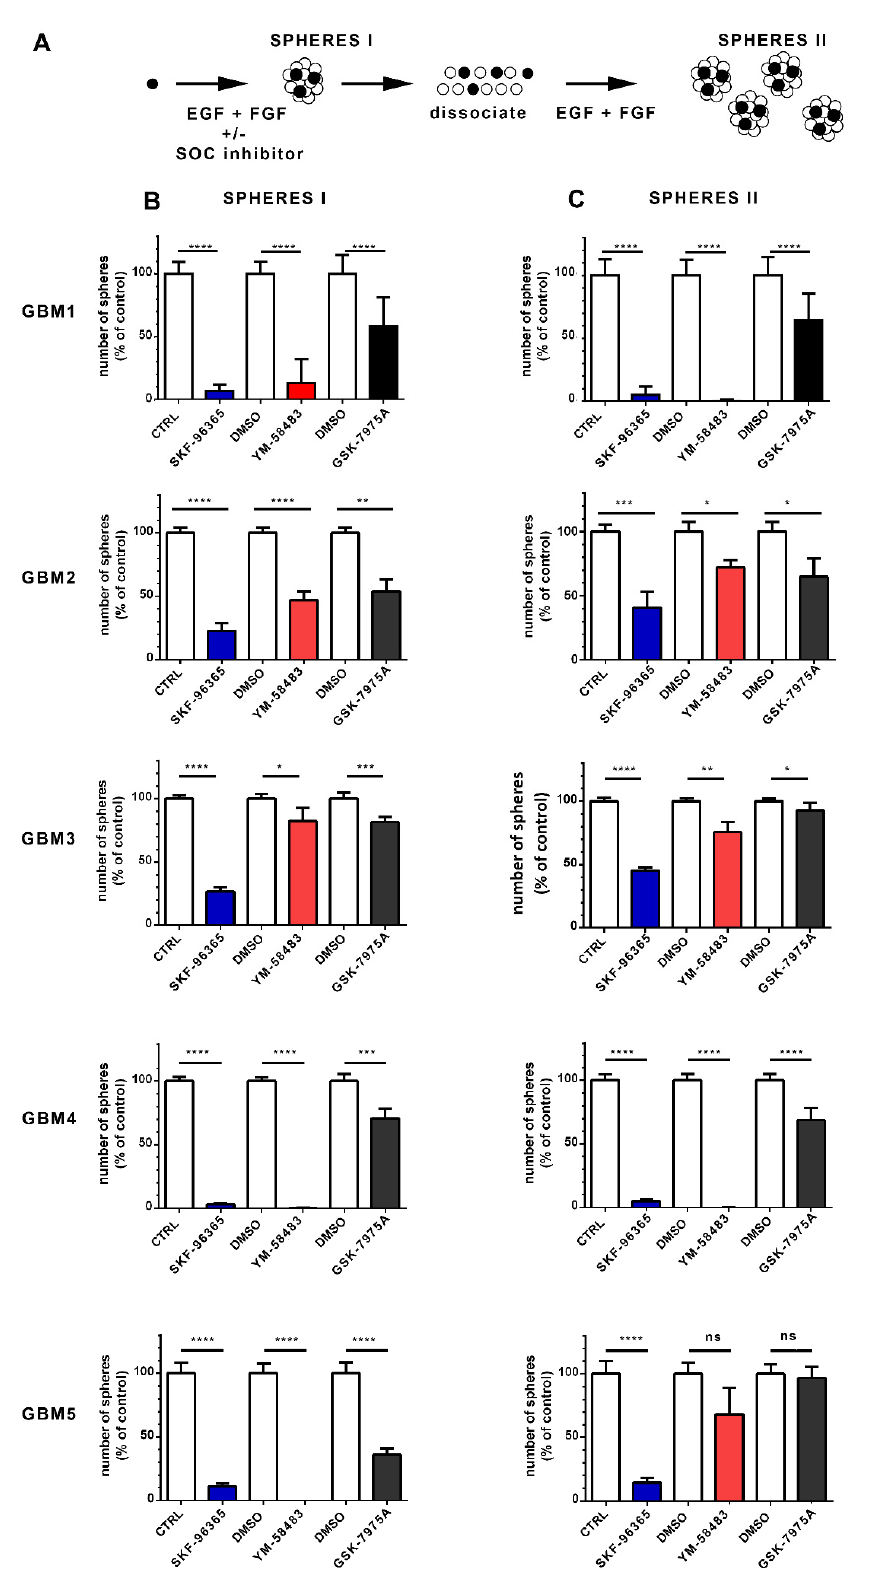
Figure 4. Pharmacological inhibition of SOC impairs the ability of GSC to form sphere and self-renew. ( A ): Schematic of the assay used to obtain the data in B and C. Stem cells represented by black circles proliferate and form spheres (SPHERES I) that contain both stem cells (black) and more